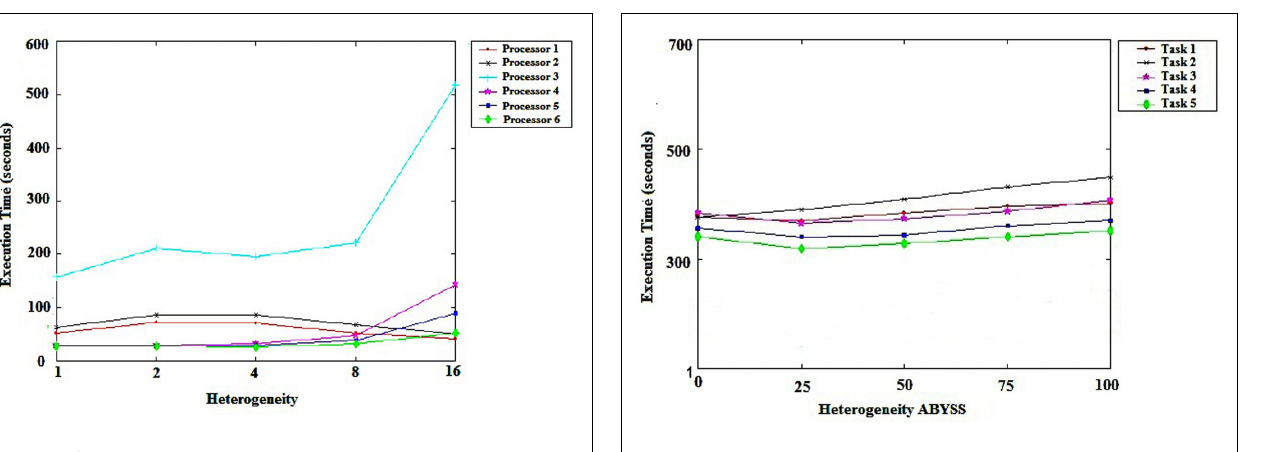
FIGURE 4 | Heterogeneity